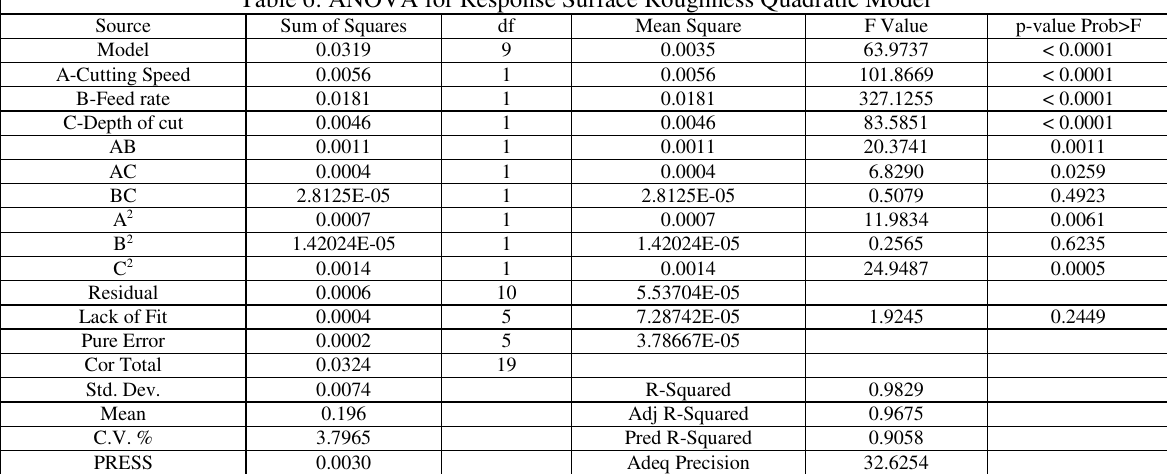
Table 6: ANOVA for Response Surface Roughness Quadratic